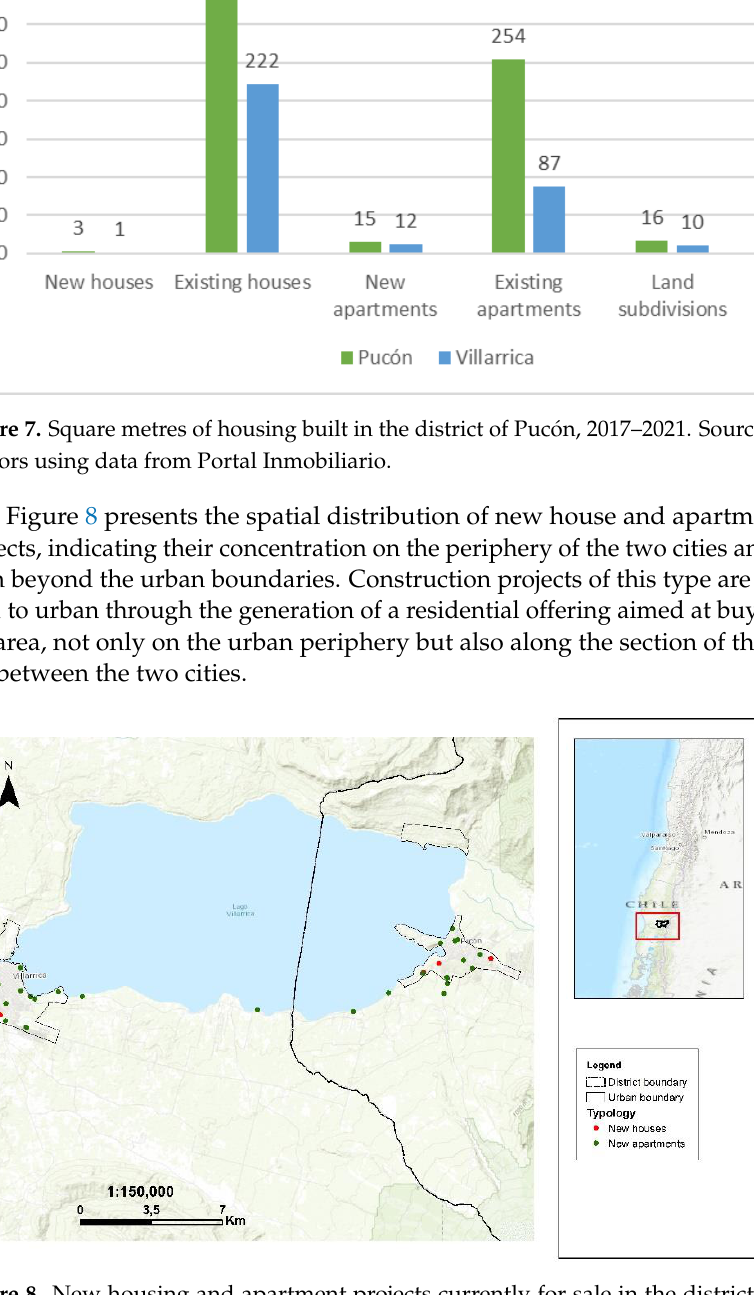
Figure 8. New housing and apartment projects currently for sale in the districts of Villarrica and Pucón. Source: compiled by the authors using data from Portal Inmobiliario dated 10 November 2021.